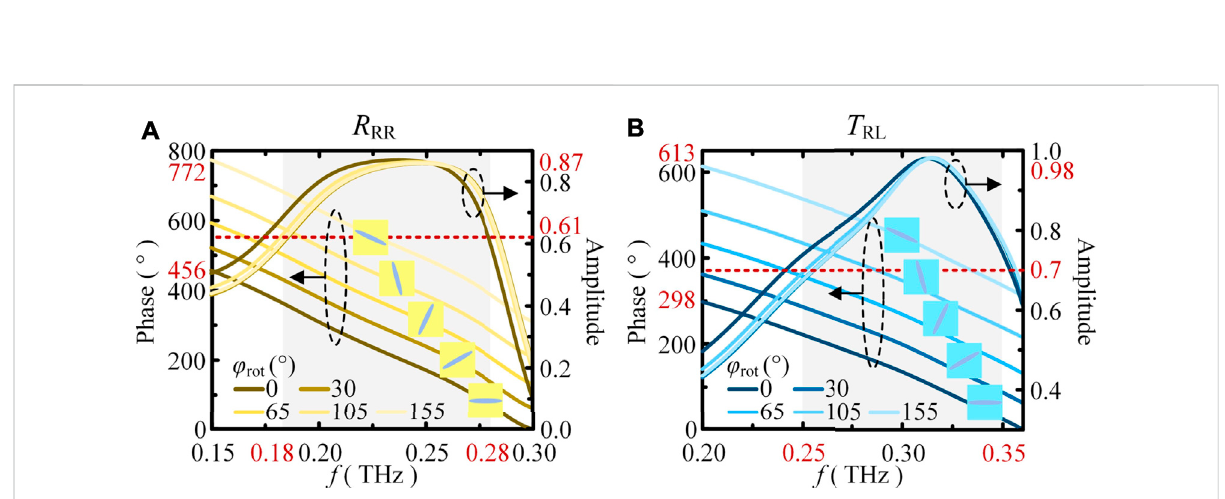
FIGURE 3 The simulated phase and amplitude versus frequency of the unit cell with φ rot = 0 ° , 30 ° , 65 ° , 105 ° , and 155 ° respectively (A) The co-polarization re fl ection coef fi cient